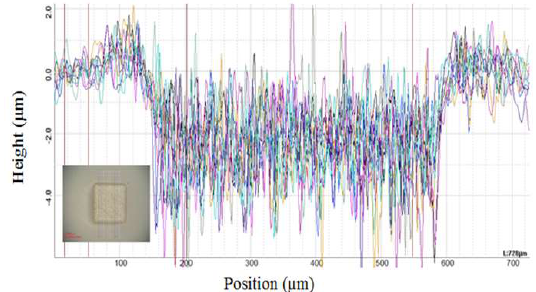
Figure 17 Optical Profilometry cross section of the HA600 depth profile.